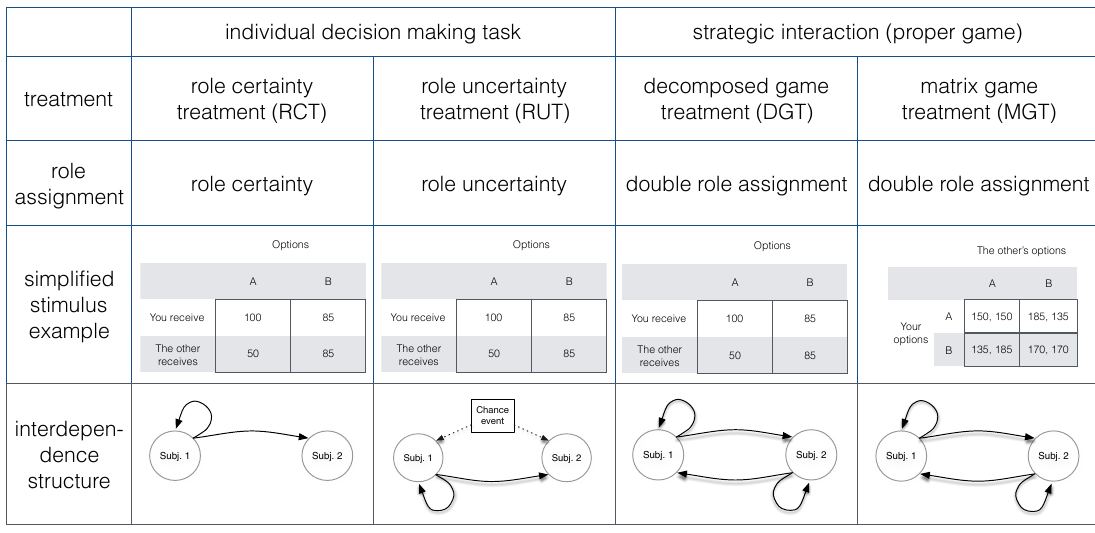
Figure 3. Experimental design. The figures in the last row show how influence propagates from a subject to affect her own payoff and the payoff of another